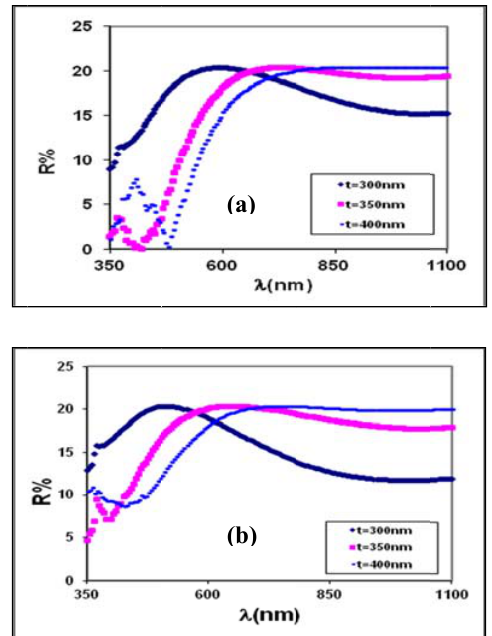
Fig. 5: The re t different th a) before rradiation.